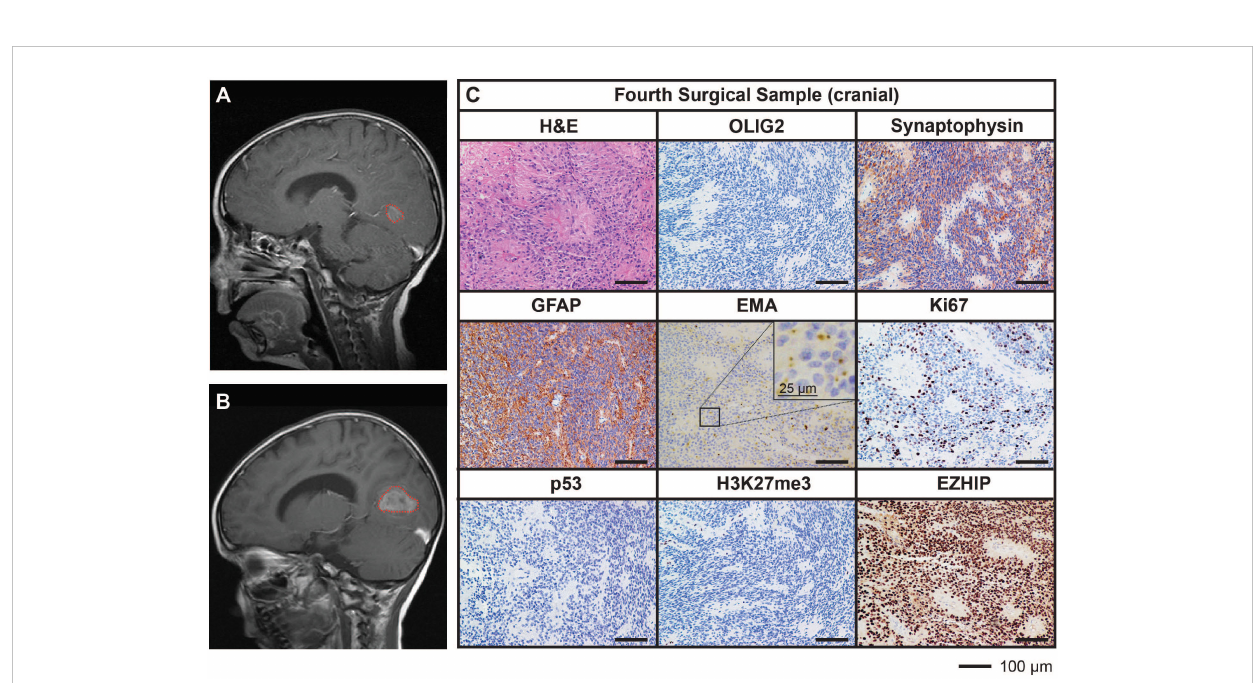
FIGURE 4 MRI and histological assessments of a cranial metastatic lesion distant from the primary PFA EPN (fourth surgical sample) has features concordant with the initial disease. (A) MRI depicting a metastatic tumor in the mesial occipital region ( red dotted line ). (B) Progression of the mesial occipital lesion ( red dotted line ) at three months following the scan shown in (A) . This tumor required surgical excision, from which a fourth surgical sample was obtained. (C) Tumor tissue was stained with H&E or using IHC with the antibodies indicated ( brown ) followed by hematoxylin counterstain ( blue ). Histological fi ndings were consistent with the features of the primary tumor. Ki67 proliferative index was similar to previous samples (25%). Scale bars are as indicated.